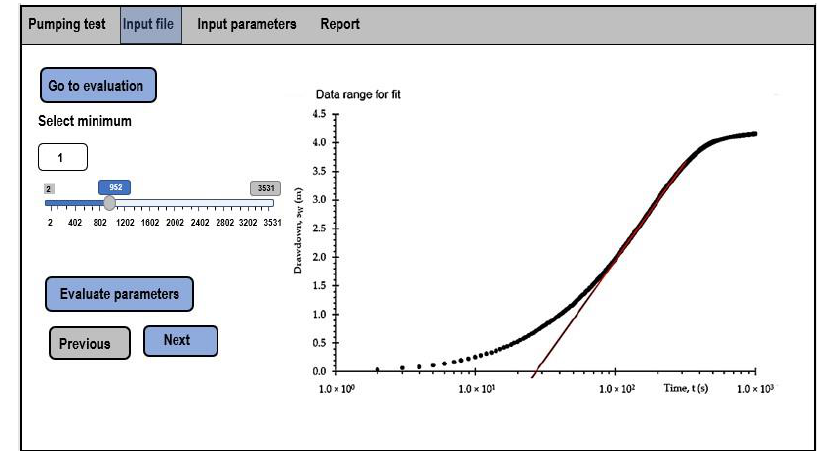
Figure 11. Dtest_ULTRA software